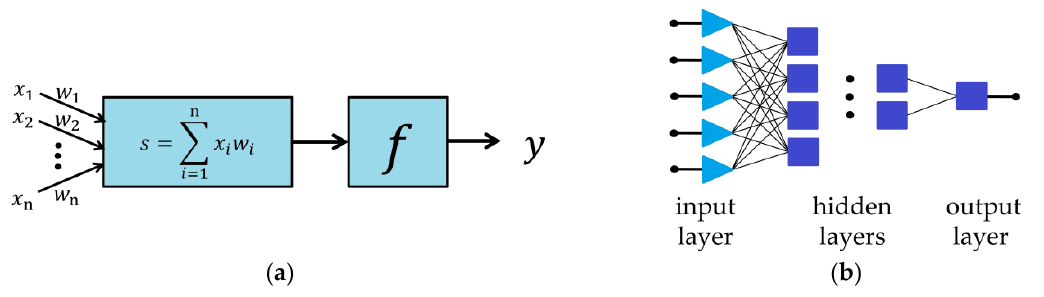
Figure 2. Model of: ( a ) neuron; ( b ) multilayer perceptron.